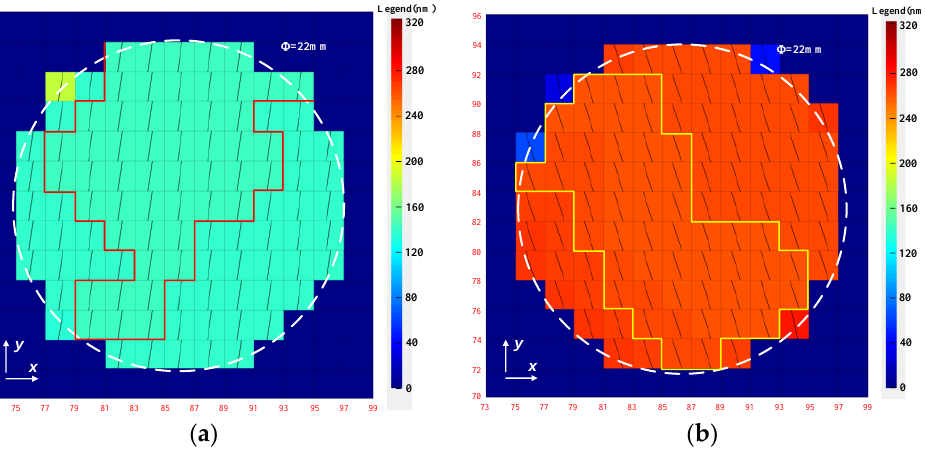
Figure 7. Waveplate parameter measurement results of the 532 nm waveplate in the entire clear aperture: ( a ) 1/4 waveplate; ( b ) 1/2 waveplate.